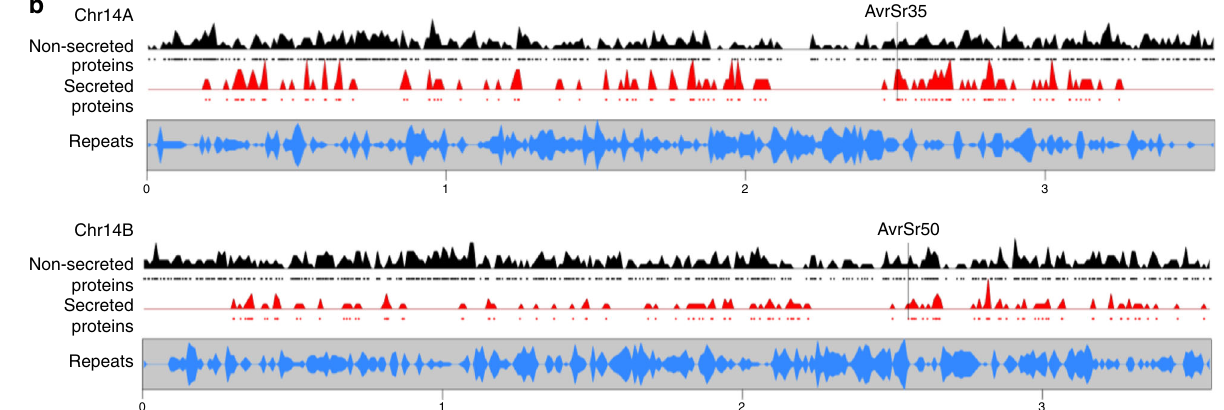
Fig. 8 Gene content of Pgt 21-0 chromosome pseudomolecules. a Circos plot showing location of orthologous gene pairs in the A and B chromosomes of Pgt 21-0. b Gene and repeat density plots for homologous chromosomes 14 A and 14B. Density of genes encoding non-secreted (black) or secreted proteins (red) along the chromosomes are shown, with individual genes indicated by black or red dots. Bottom graph shows density of repeat elements (blue). Positions of AvrSr50 and AvrSr35 genes are